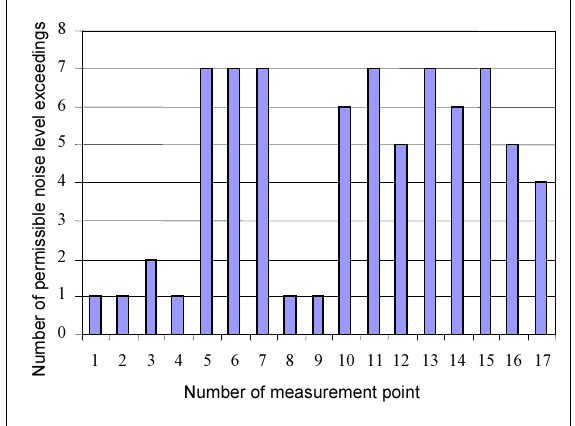
Fig. 3. Number of the excesses of permissible noise level